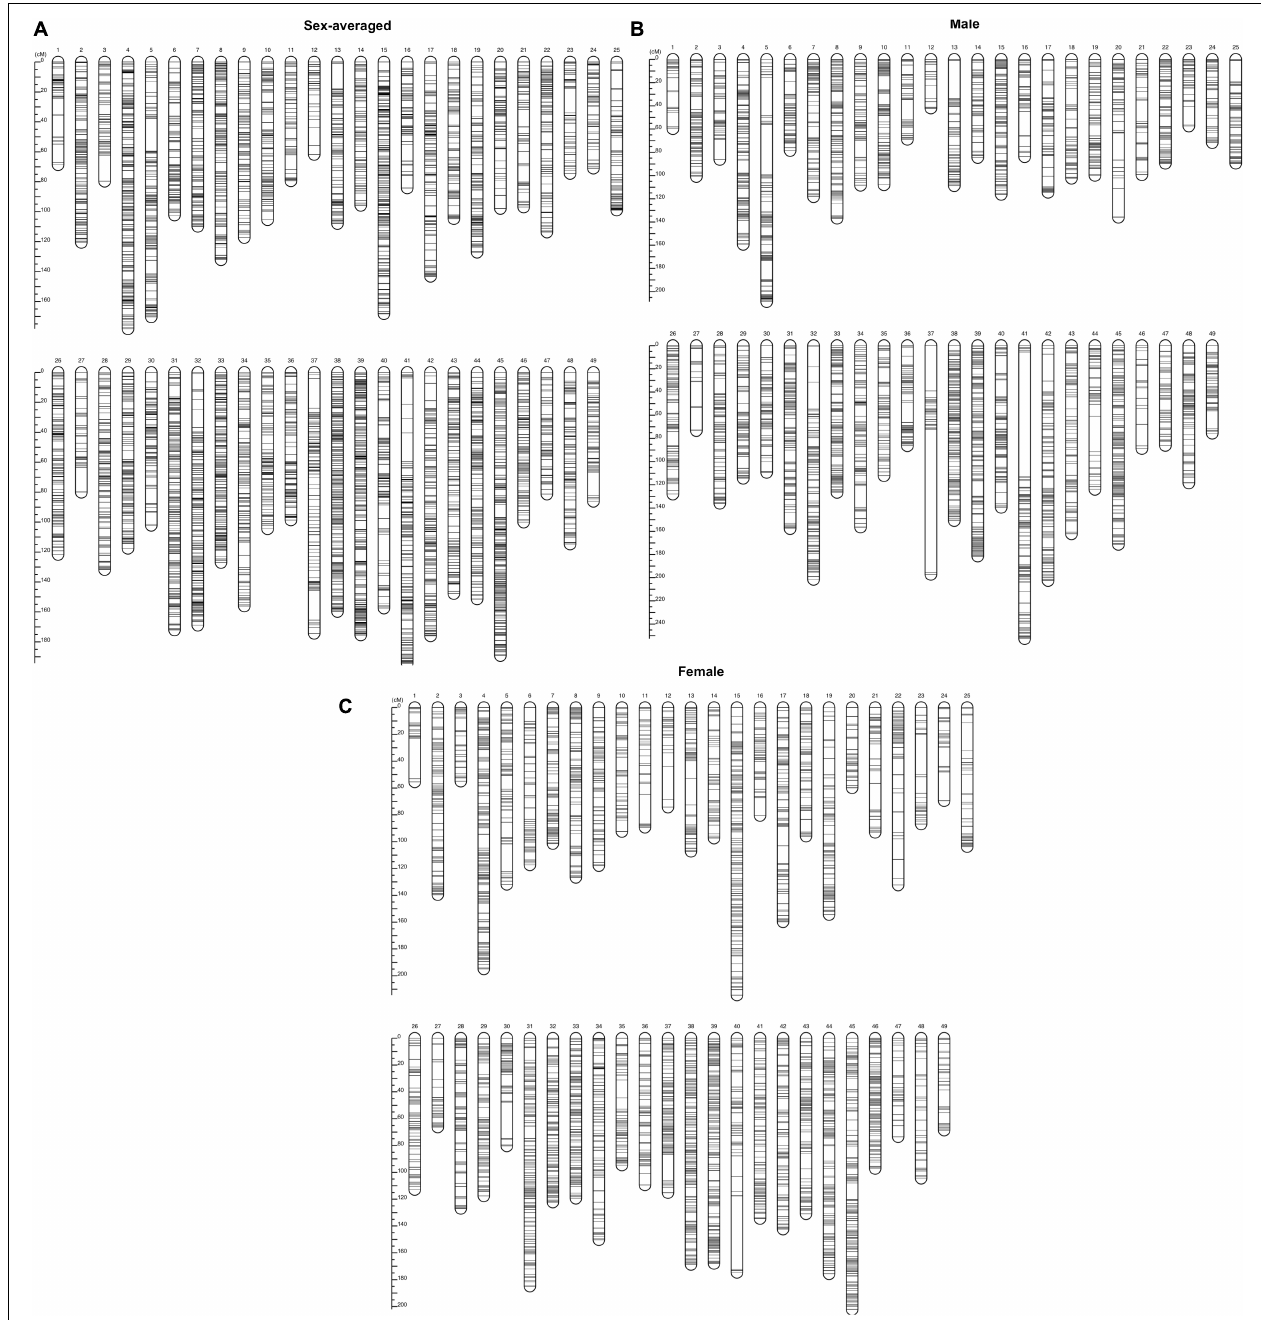
FIGURE 1 | The genetic linkage maps of (A) sex-average, (B) male, and (C) female Scylla paramamosain .